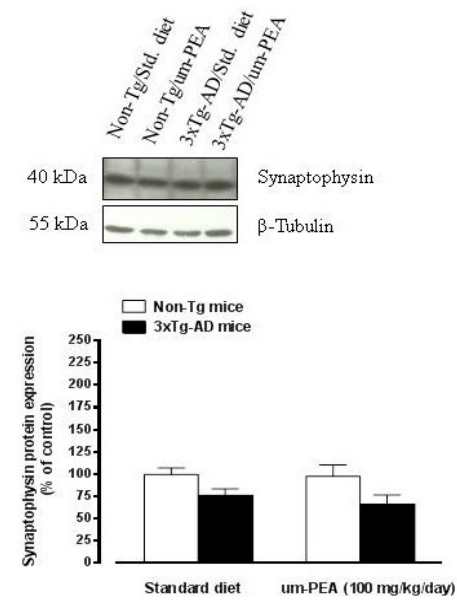
Figure 6. Oral ultramicronized palmitoylethanolamide treatment did not affect synaptophysin levels in the hippocampus of non-Tg and 3×Tg-AD mice. Age-matched non-Tg mice and 3×Tg-AD mice (2 months ± 2 weeks of age) have been orally treated for 3 months with the compound (100 mg/kg/day, added to the animal food), while control animals were fed with a standard diet during the treatment period. Representative western blot densitometric analysis of synaptophysin is reported above the graph. Western blot analysis was performed on hippocampus tissues taken from mouse brains at the end of the treatment period. Experiments were performed three times in triplicate and β -Tubulin was used as loading control. Results are expressed as percentage of the mean ± SEM of control value (i.e., standard diet fed non-Tg mice).